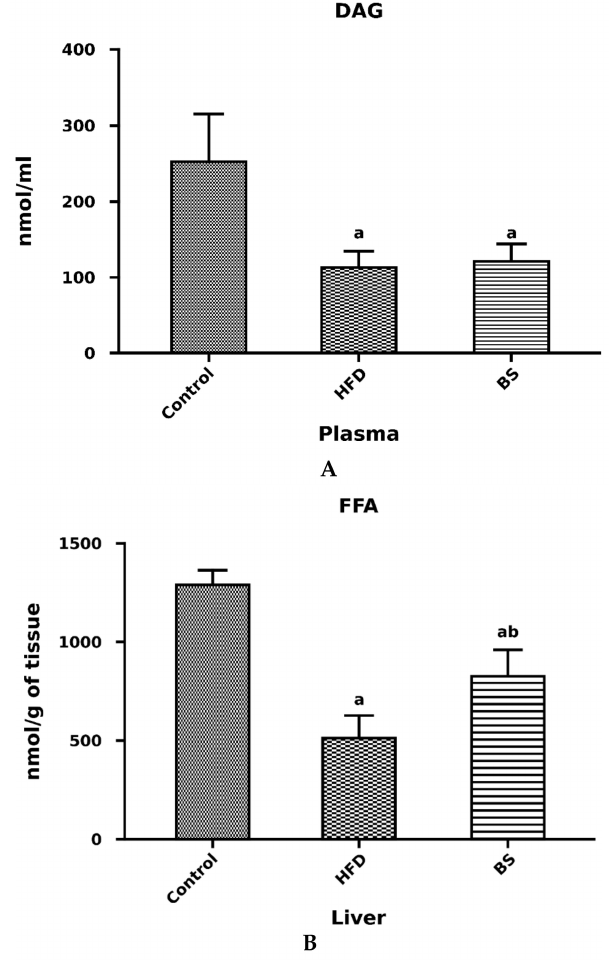
Figure 3. Concentrations of diacylglycerols (DAG) (nmol / mL) in blood plasma ( A ) and FFA (nmol / g of tissue) in the liver ( B ). Bar heights correspond to averages and error bars represent standard deviations. Statistical significance markers: a—vs. Control ( p < 0.05), b—vs. HFD ( p <